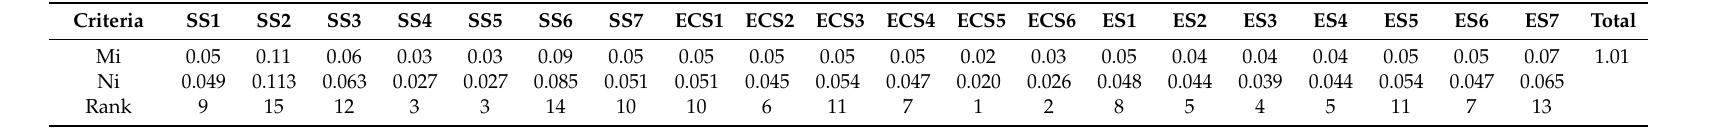
Table 9. The average, normalized weight, and rank of criteria for